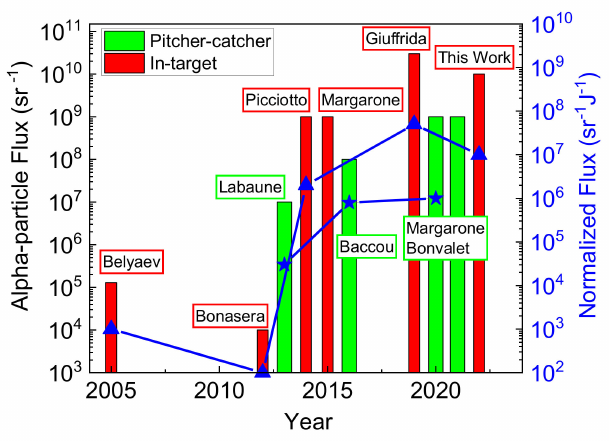
Figure 1. The experimental progress in p–B fusion, measured in terms of α -particle production in the “in-target” [2–4,7,14] and “pitcher–catcher” [5,6,8,15] geometries. The left-hand scale indicates the absolute α -particle flux (particles/sr), while the right-hand scale is normalized to the laser energy delivered on target